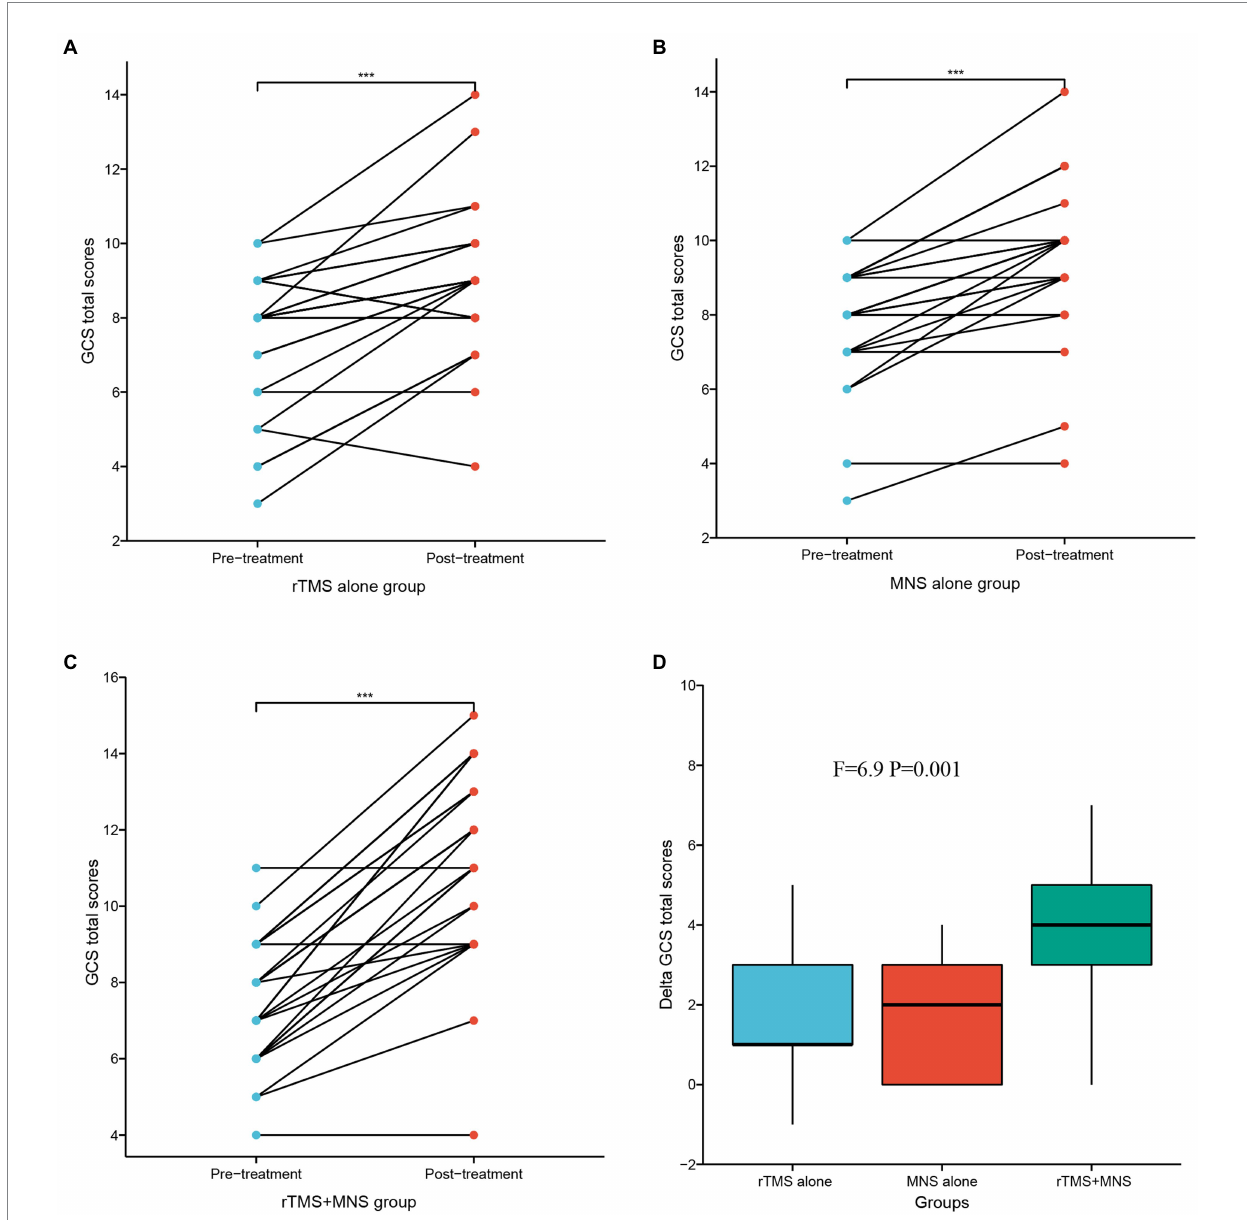
FIGURE 3 GCS total scores following 4 weeks of treatment for the rTMS alone, MNS alone and rTMS+MNS groups. A significant increase in the GCS scores compared with pre-treatment in the (A) rTMS alone, (B) MNS alone and (C) rTMS+MNS. (D) The changes in GCS scores between the three groups were statistically significant. ***means p <